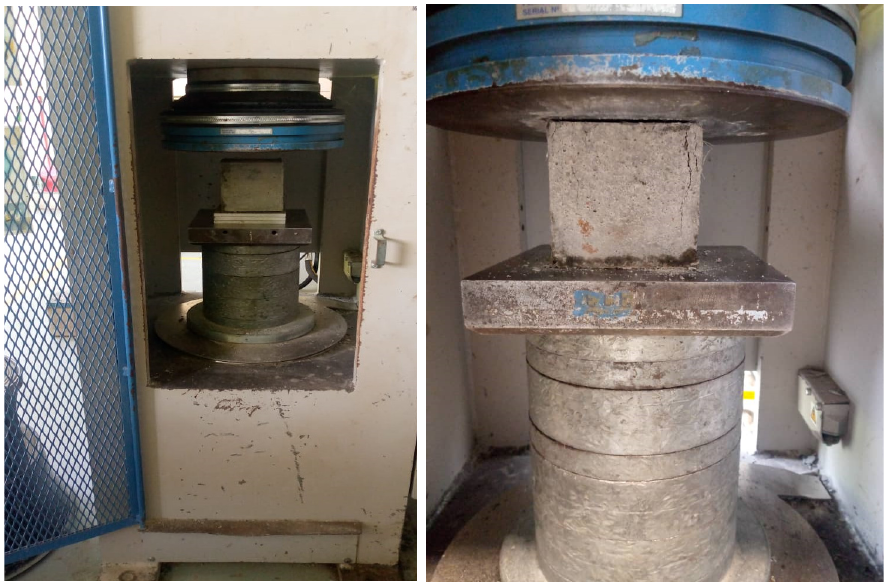
Figure 4. Compressive strength laboratory testing.